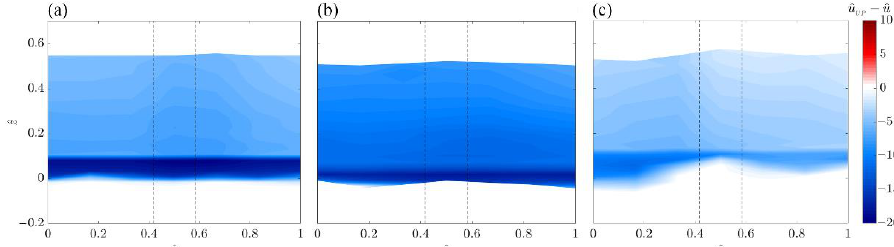
Figure 7. Contours of the dimensionless time-averaged accelerated ( ˆ u UP − ˆ u ) < 0 and decelerated − ˆ u ) > 0 flow field in the longitudinal plane section (from RE to RV) for ( a ) Run 1, ( b ) Run 2 ( ˆ u UP and ( c ) Run 3. The black dashed lines show the cylinder